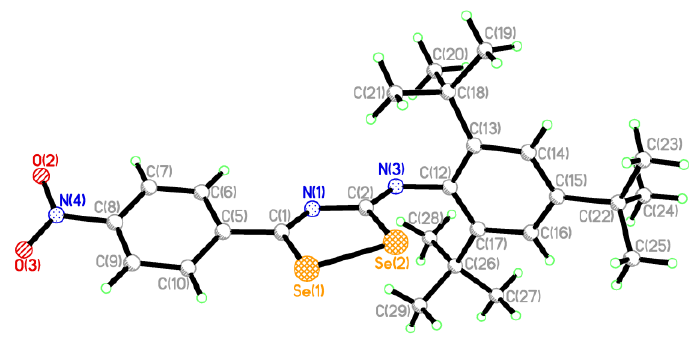
Figure 3. Single crystal X-ray structure of compound 3 (hydrogens represented as small green spheres). Se(1)-Se(2) 2.3118(12)[2.3116(12)], Se(1)-C(1) 1.925(8)[1.910(7)], Se(2)-C(2) 1.970(8)[1.952(7)],